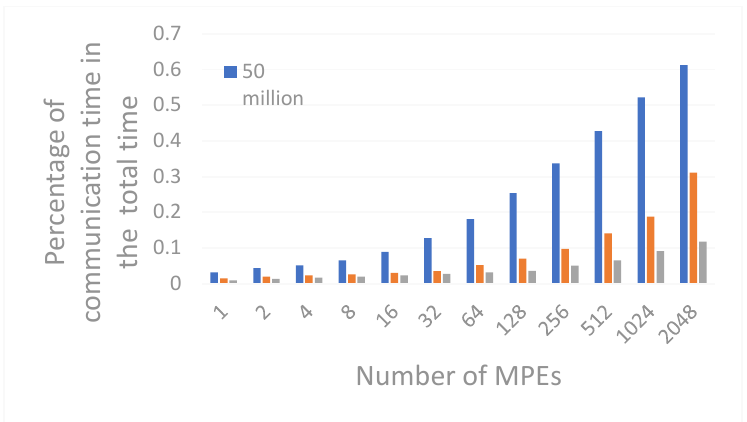
Figure 9. Communication time as a percentage of total time for only MPEs at three problem sizes.